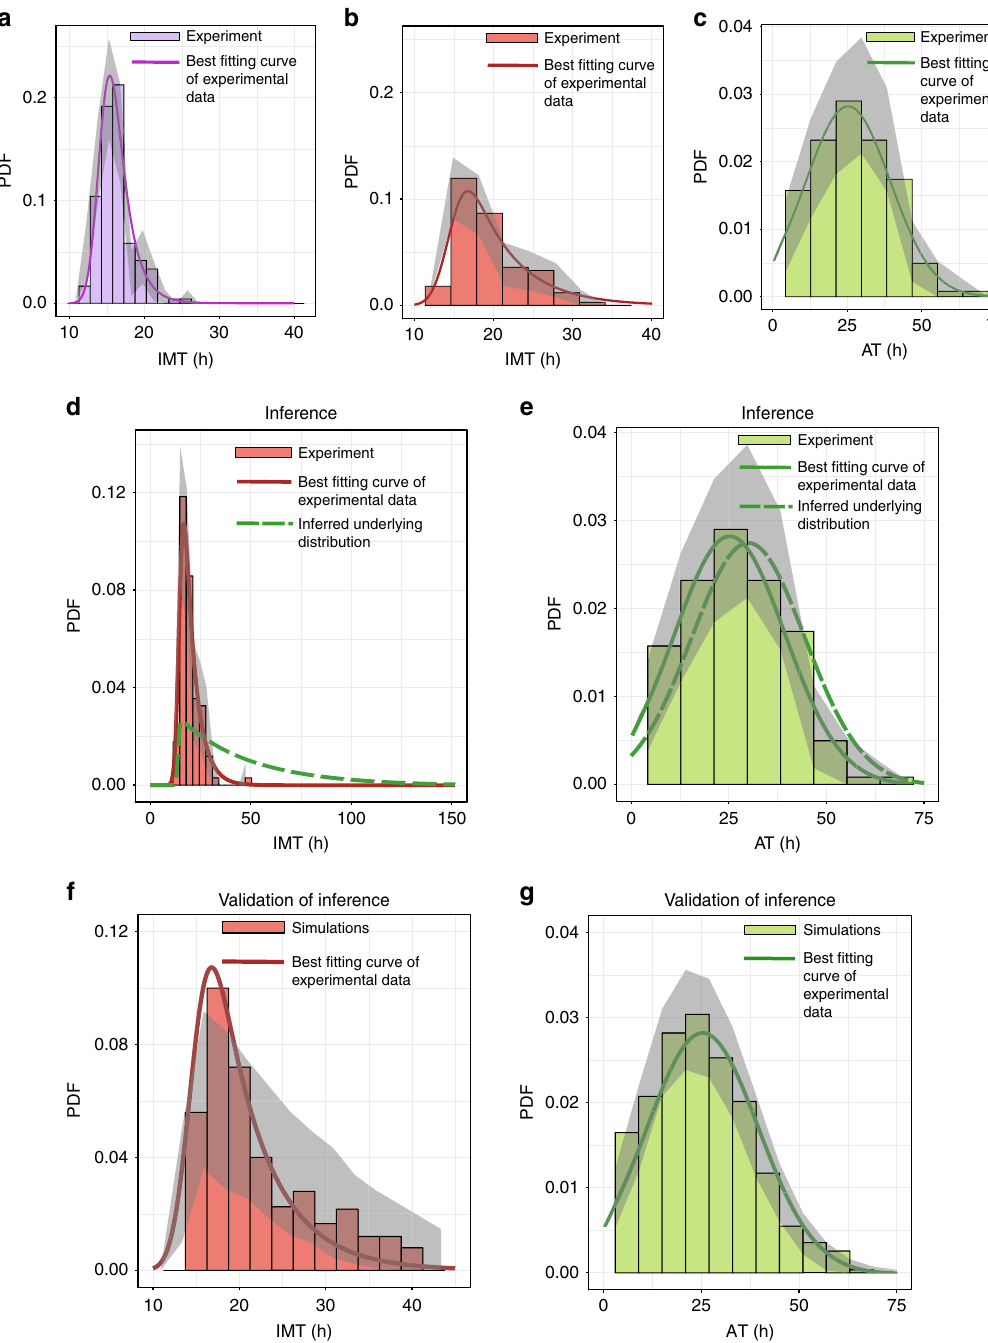
observed due to the earlier occurrence of the competing fate. As a result, the observed times to both division and death are skewed towards shorter times; the extent of this bias depends on how much the underlying IMT and AT distributions